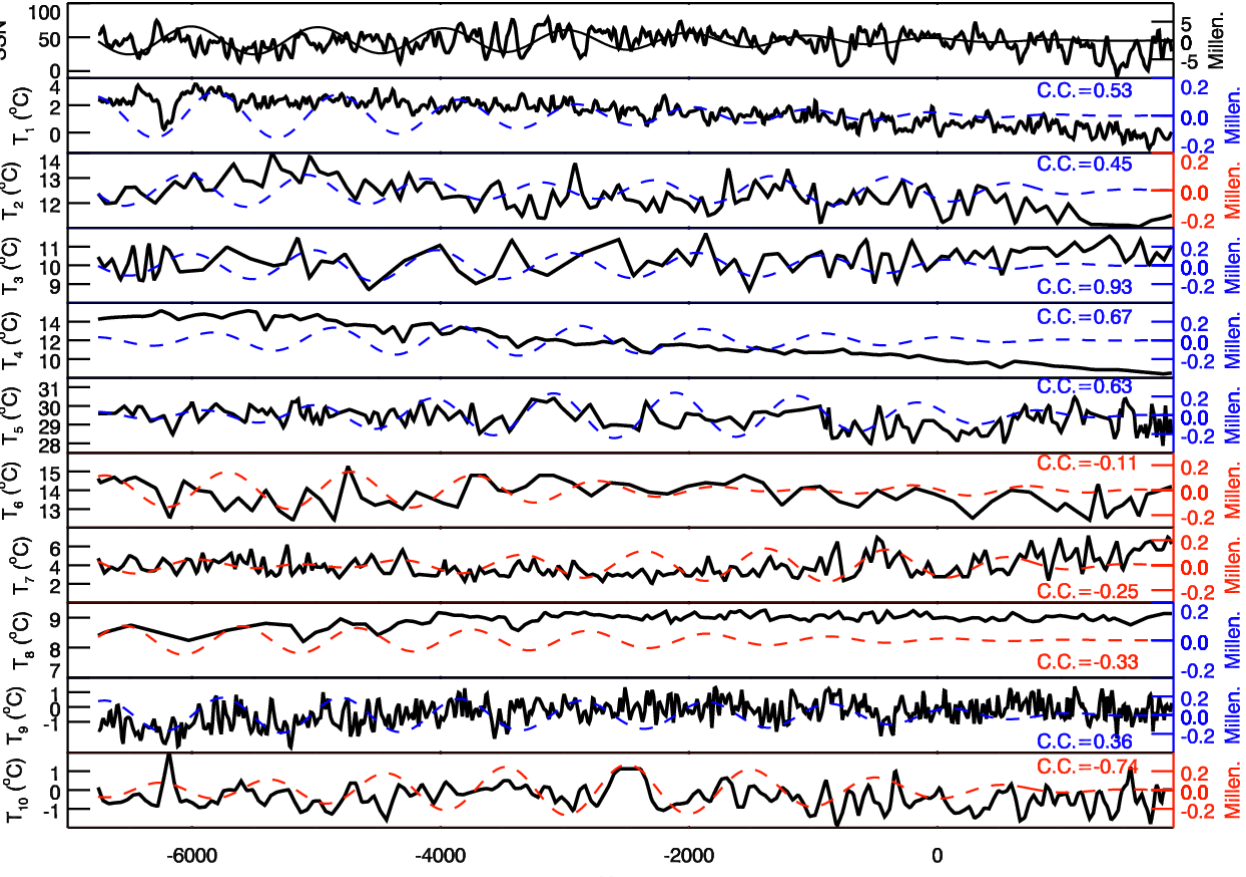
Figure 5. Comparison between SSN and temperatures (thick lines) and their 1000-year cycle components (thin lines). Blue lines represent temperatures positively correlated with SSN, while red lines represent temperatures negatively correlated with SSN. See text for results and discussion as well as summary in Table 1, Table 2, and Figure 1.